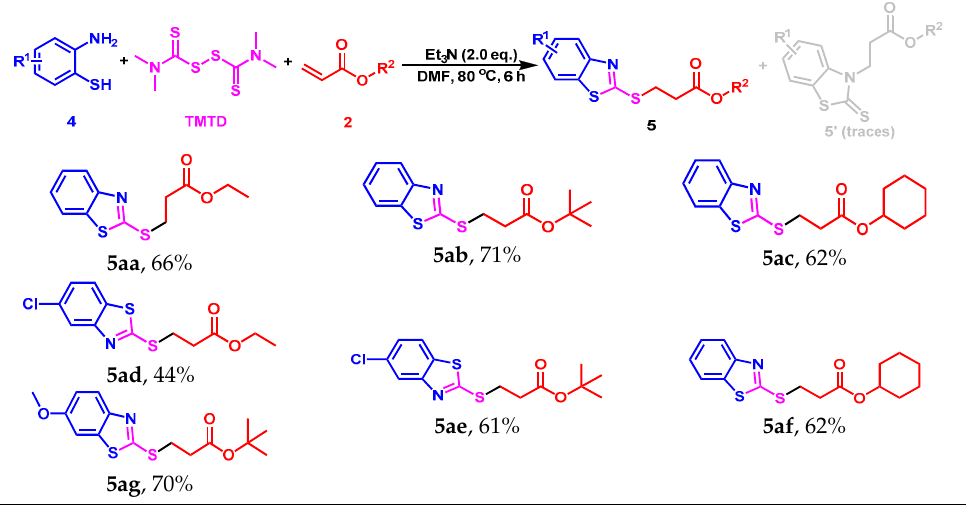
Figure 3. X-ray crystallography of by-product 5ag’ .